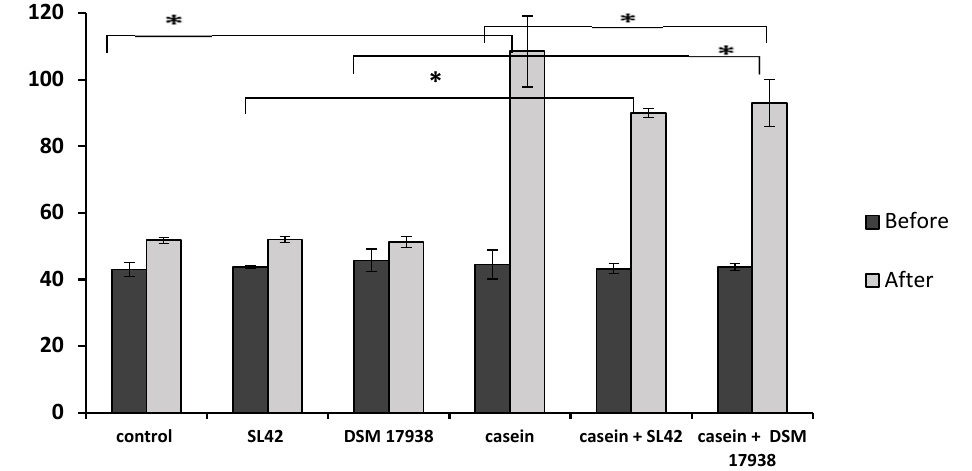
Figure 5. Eosinophil numbers in blood as determined using hemogram technique (n = 8 rats/ group). Wistar rats were sensitized intragastrically by administration of casein without adjuvant (before 1st day, after 58th day). Data are presented as the mean ± SD. Statistical analysis was conducted by using one-way ANOVA with Tukey’s multiple comparisons test. * p < 0.05. Control group receiving only PBS (control group); nonsensitized group treated with SL42 strain (SL42 group); nonsensitized group treated with DSM 17938 strain (DSM 17938 group); casein-sensitized group (casein group); casein-sensitized group treated with SL42 (casein + SL42 group); and casein-sensitized group treated with DSM 17938 strain (casein- + DSM 17938 group).